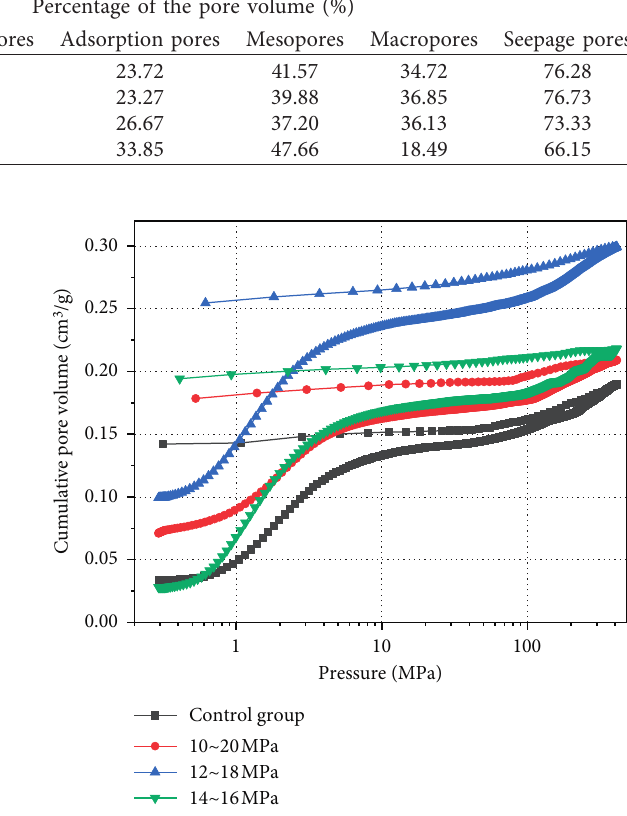
Figure 8: Mercury-intrusion curves of samples at different loading